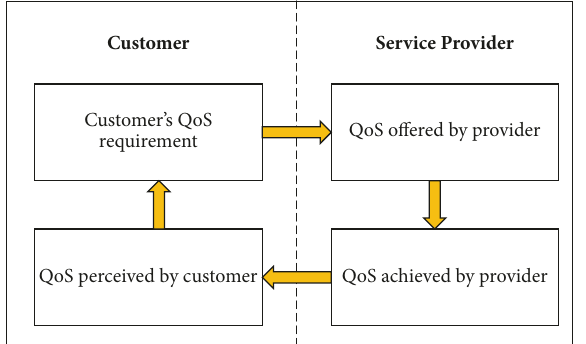
Figure 3: Four Viewpoints of QoS